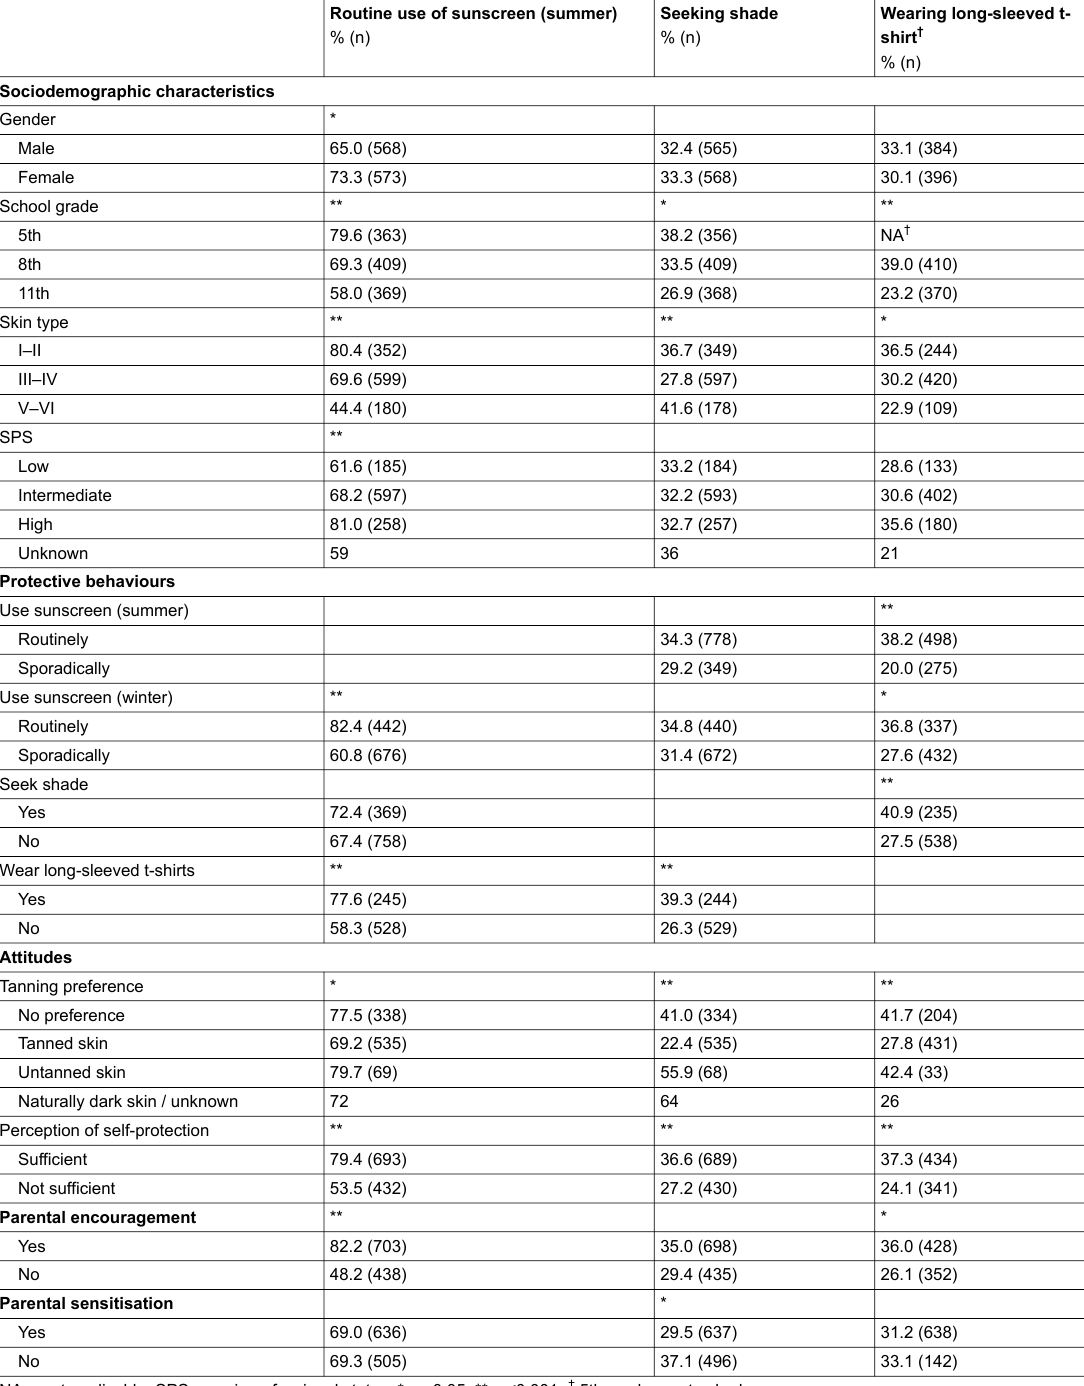
Table 4: Prevalence (in %) of various sun protective behaviours.